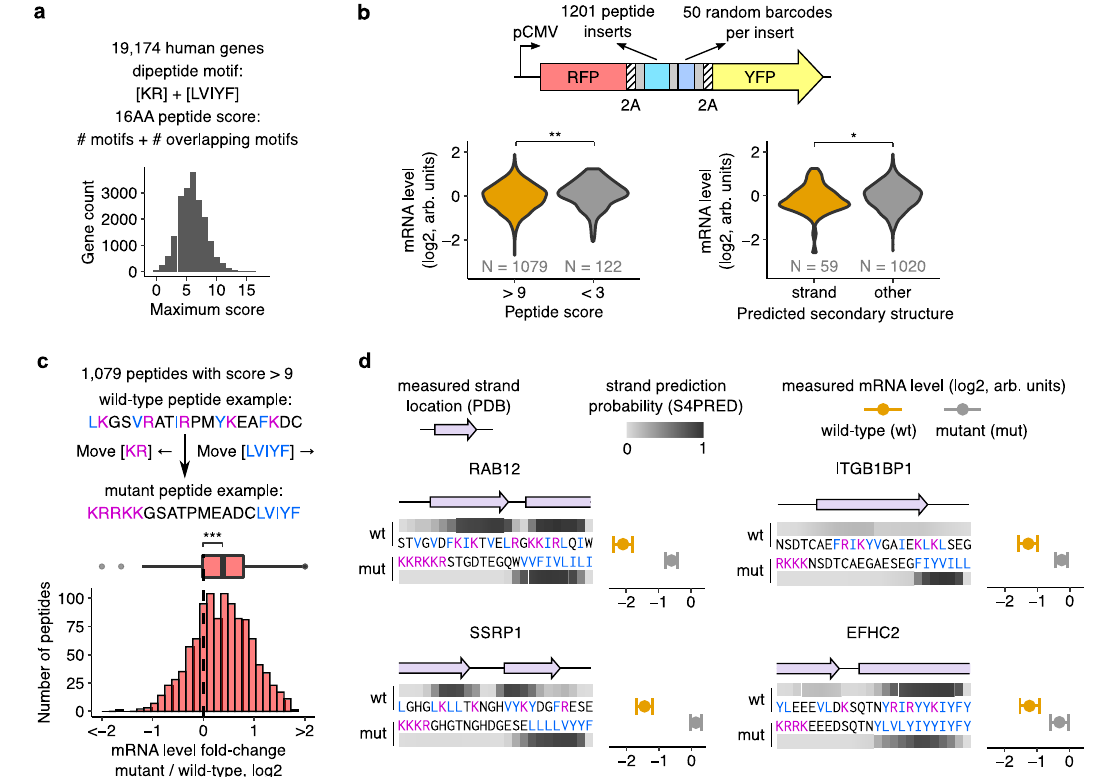
Fig. 5 | Dipeptide motifs in the human genome reduce mRNA levels. a Scoring methodology fordipeptidemotifs in humanCDS.Destabilizing dipeptides formed by lysine (K) or arginine (R) with an adjacent leucine (L), valine (V), isoleucine (I), tyrosine (Y), or phenylalanine (F) are given a score of 1. If two such dipeptides overlap, an additional score of 1 is given. The 16 amino acid peptide window with the maximum scoreisidenti fi edin eachCDS,and the distribution of these peptide scores across all genes is shown in the lower panel. b mRNA levels of destabilizing (peptide score >9) and control motifs (peptide score <3) are measured by pooled cloning (1201 total inserts) into a reporter construct followed by deep sequencing as in Fig. 1a. Left panel: Distribution of measured mRNA levels of destabilizing dipeptidemotifs compared to control motifs ( P =0.004).Rightpanel: Distribution of measured mRNA levels of destabilizing dipeptide motifs in the left panel parti- tioned by predicted secondary structure ( P =0.022). 59 motifs with an average β strand prediction probability >0.5 using S4PRED are classi fi ed as β